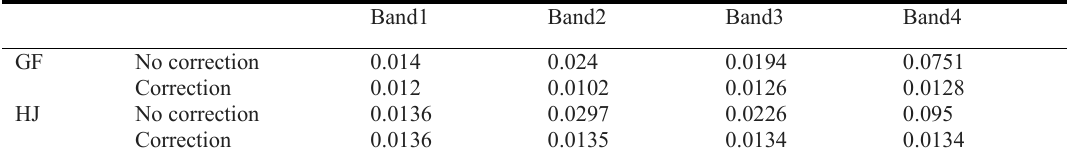
Table.3.2. The topographical correlation factor between multi-source image and Landsat8 OLI